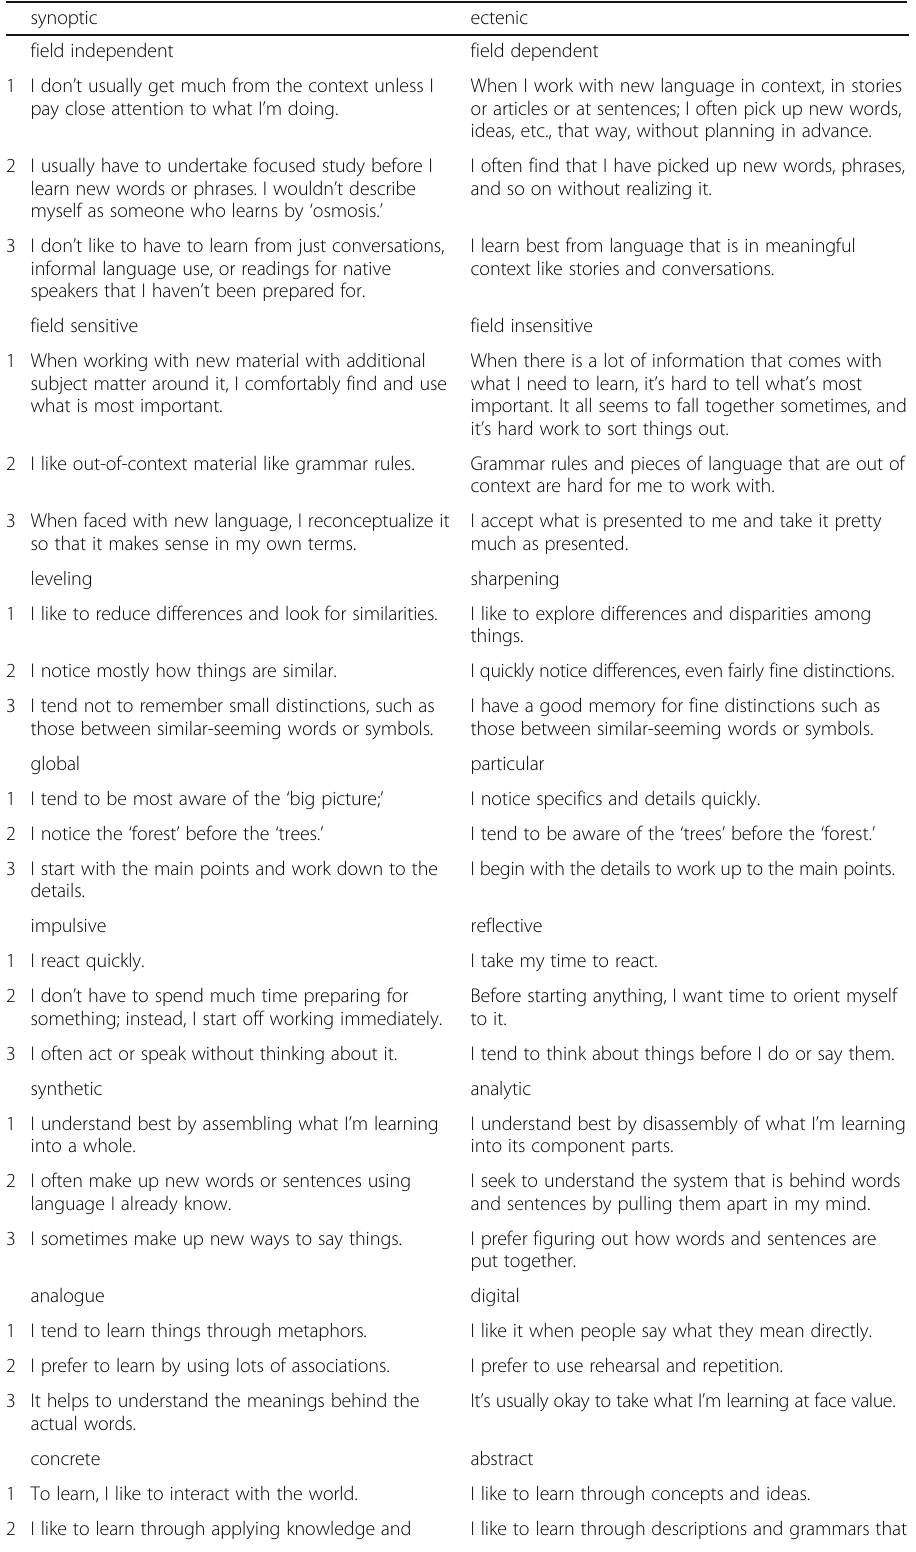
Table 5 The Ehrman and Leaver Learning Style Questionnaire (Ehrman & Leaver, 2002) synoptic